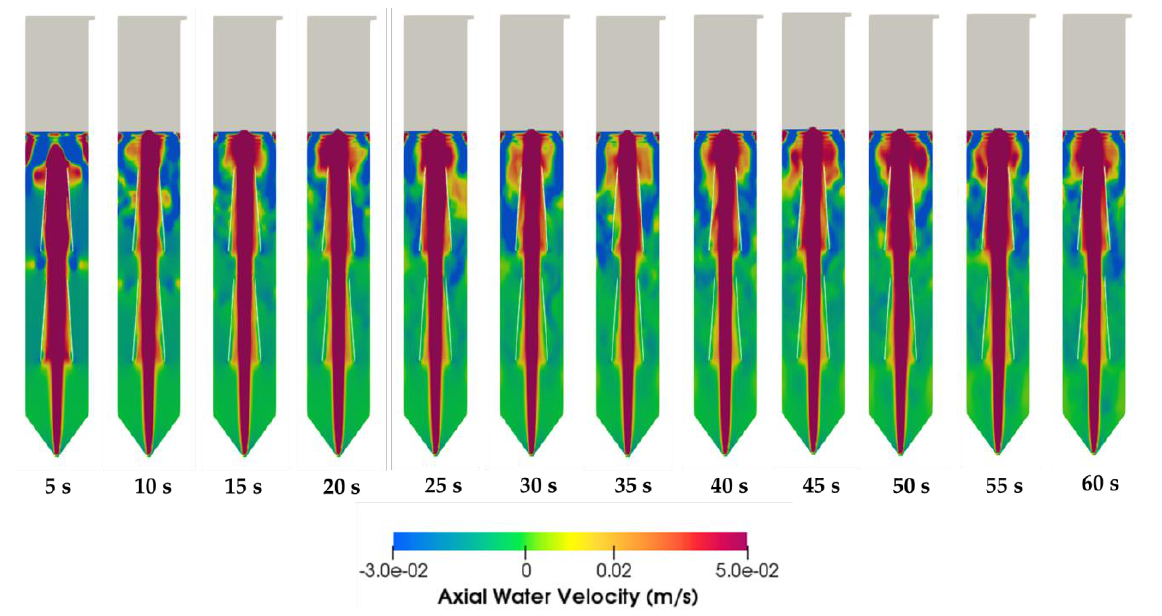
Figure 11. Axial water velocity of geometry 9 with 5 s interval for 60 s. Figure 12, colors the downcomer axial velocity of geometries 1, 2, 7, 8, 9 and 10. To ignore the riser velocity, the maximum velocity was set to zero and the minimum velocity was set to − 0.01 m/s. Selecting a darker color for the minimum velocity gives an adequate graphical representation of the maximum downcomer velocity. On the left of Figure 12, it can be seen that the downcomer invades the riser section of the bottom draft tube geometries. Reducing diameter of the top section of the bottom draft tube eliminates this phenomenon, as shown on geometries 7–10 of Figure 12. On Figure 12, it can be seen that when there is the presence of a funnel draft tube on the bottom of the reactor a dead zone is created on the corners before the conical bottom transition.